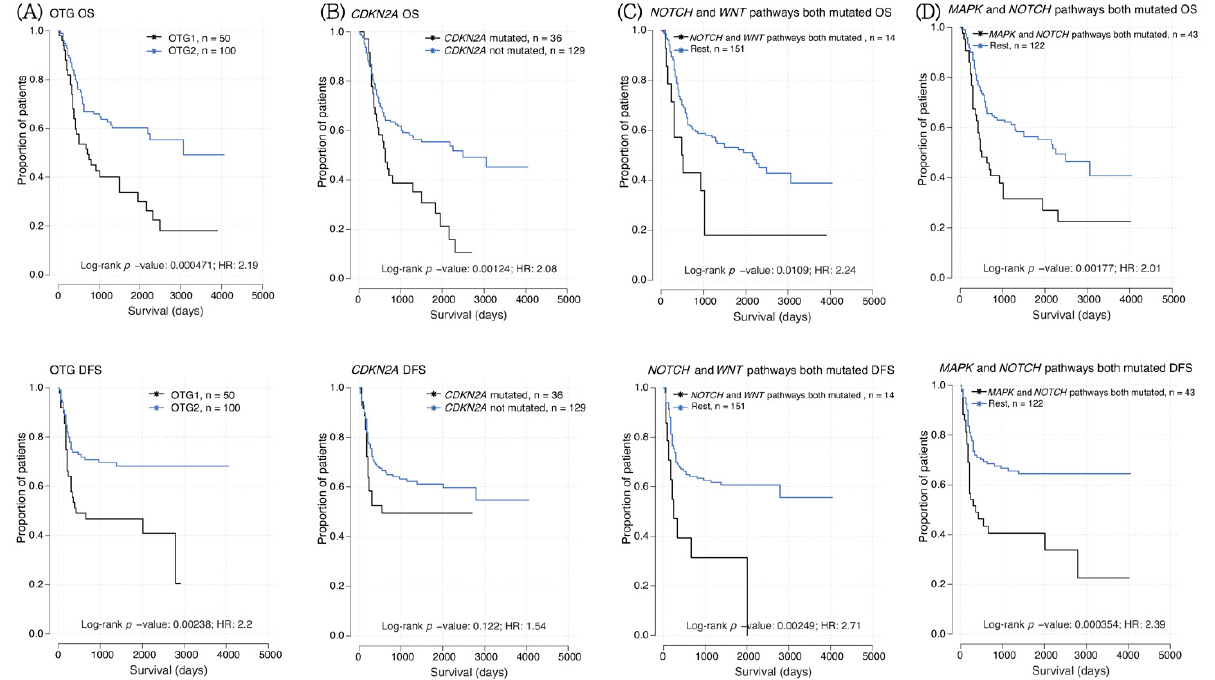
Figure 3. Impact of specific mutations on disease-free survival (DFS) and overall survival (OS) and in oral cavity squamous cell carcinoma. Kaplan–Meier survival curves for OS and DFS based on patients with mutations in ( A ) OCSCC tumor group 1 and 2, ( B ) CDKN2A, ( C ) NOTCH and WNT signaling pathways, ( D )NOTCH and TGF-beta signaling pathways, respectively.